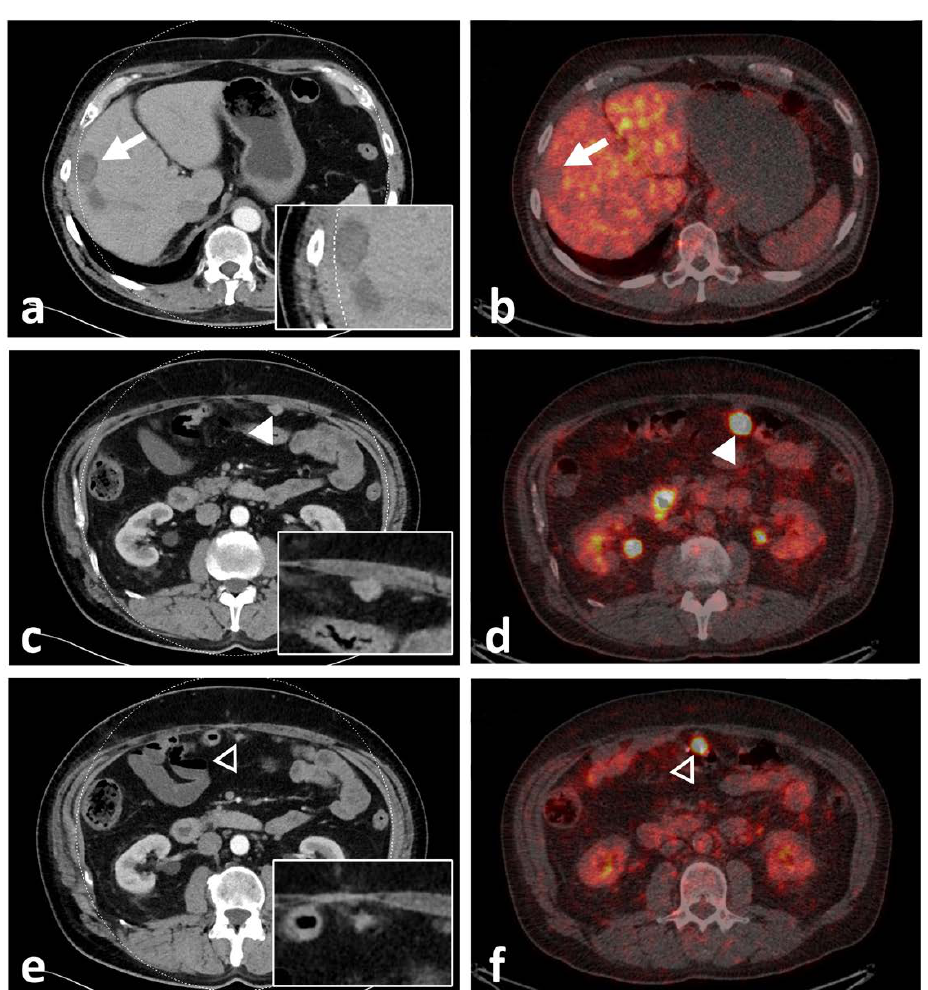
Figure 6. Computed tomography (CT) with inserted magnifications (left) and axial fused PET/CT images (right) of participant 9, demonstrating lack of uptake of 68 Ga-NeoBOMB1 in a mildly enhancing liver metastasis (white arrow, ( a , b )) and two omental metastases with significant tracer uptake ( c , d ) [white arrowhead] and ( e , f ) [black arrowhead]). The latter lesion was missed upon initial staging by CT.